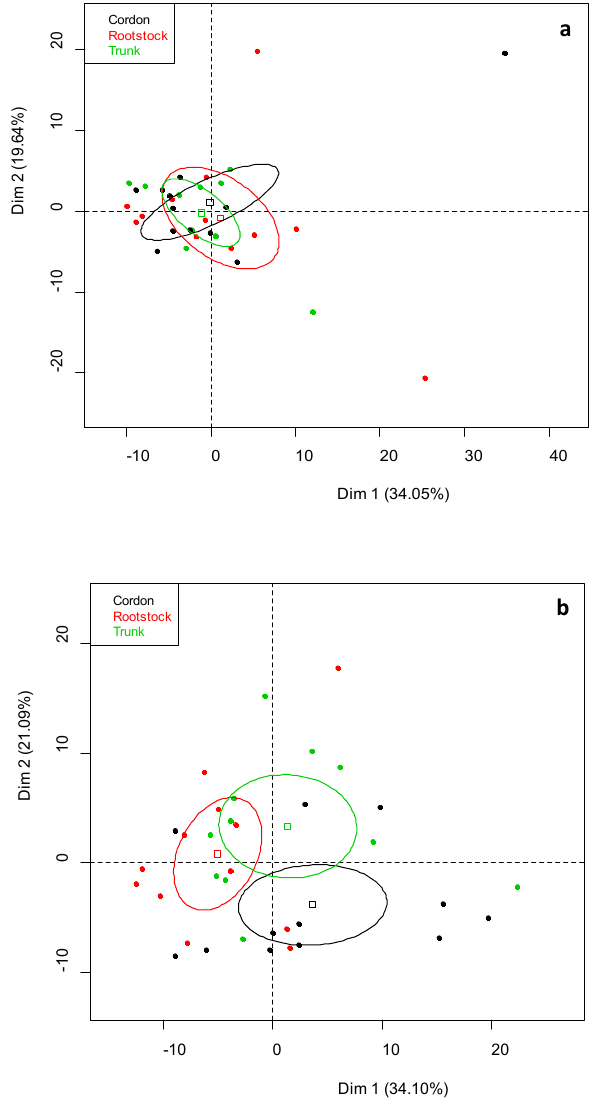
Figure 3. Principal component analyses (PCA) of fungal (a) and bacterial (b) communities colonizing the non-necrotic tissue of cordons, trunks or rootstocks of esca-foliar symp- tomatic or asymptomatic ‘Cabernet Sauvignon’ grapevines, based on SSCP profiles. The variation (%) explained by each PCA axis is given in parentheses. PCA eigenvalues indicate that the first two components, Dim 1 and Dim 2, account for a percentage of the total bacterial variability. Squares cor- respond to individual SSCPs and ellipses to the 95% confi - dence intervals calculated for each